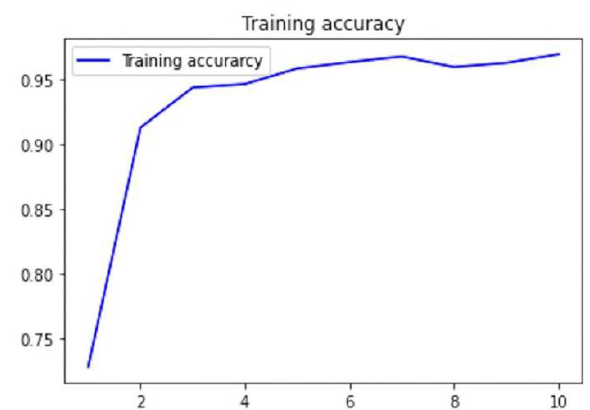
Fig.3. Training accuracy graph for 8000 images train set with 10 epochs